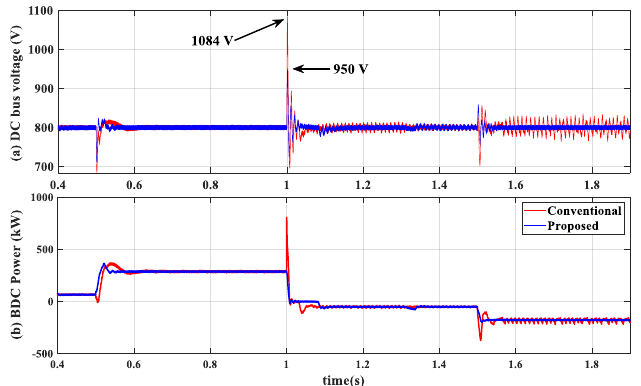
Figure 19. Inductor currents in voltage control mode for Case I.